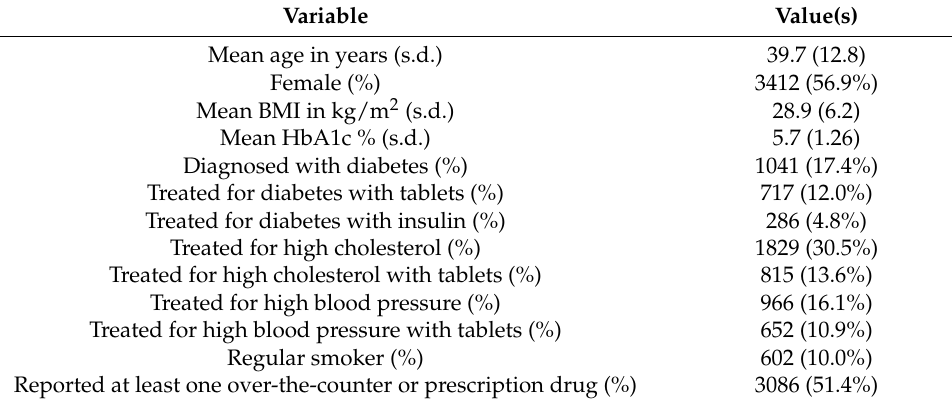
Table 1. Demographics of the 6000 QBB participants who were included in this study. Except for HbA1c and BMI, all information is self-reported using questionnaires dispensed at baseline. Variable Value(s) Mean age in years (s.d.)